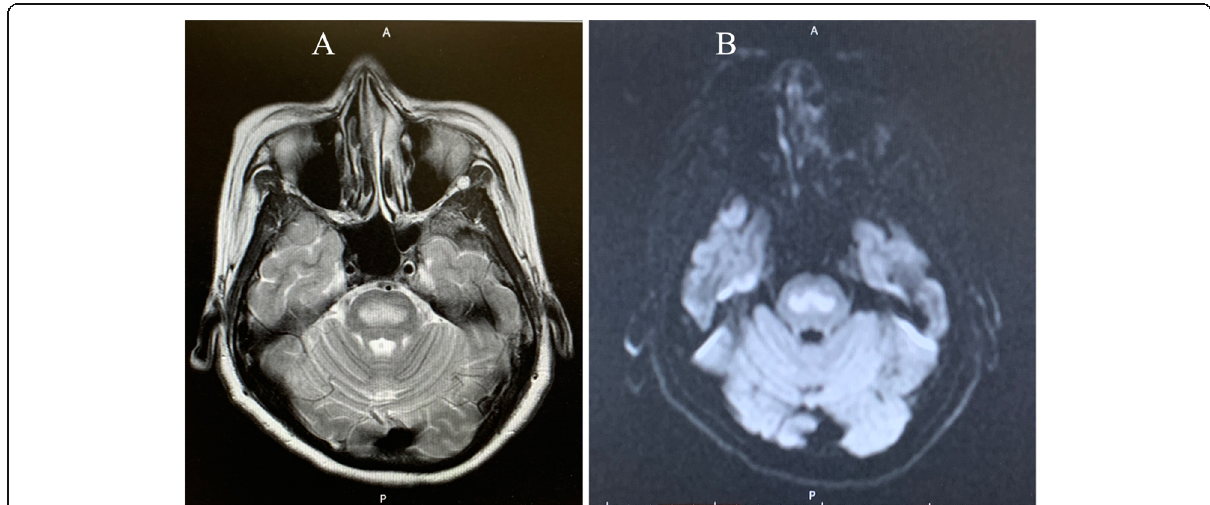
Fig. 1 Cerebral magnetic resonance imaging showing hypersignals in the central pons and medial cerebellum in both the T2 weighted ( a ) and the diffusion-weighted images ( b